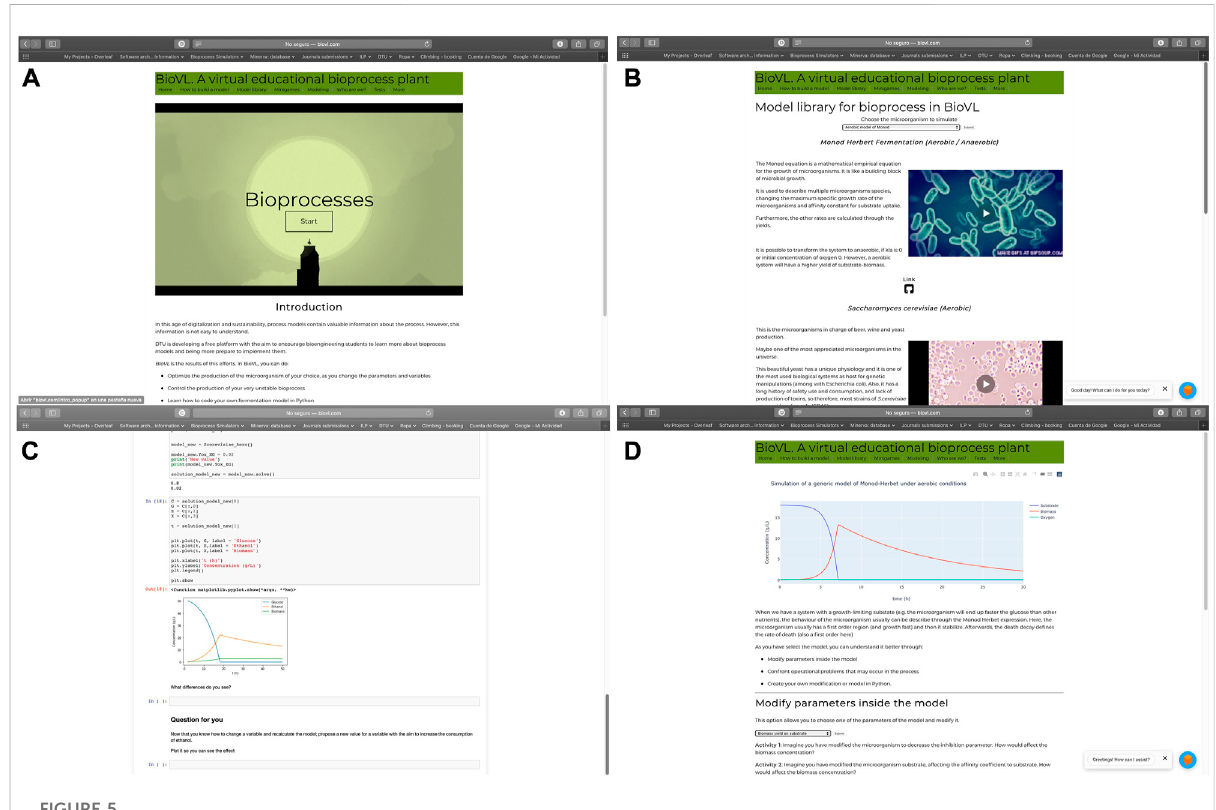
FIGURE 5 Online software prototype. (A – D) demonstrate the different software